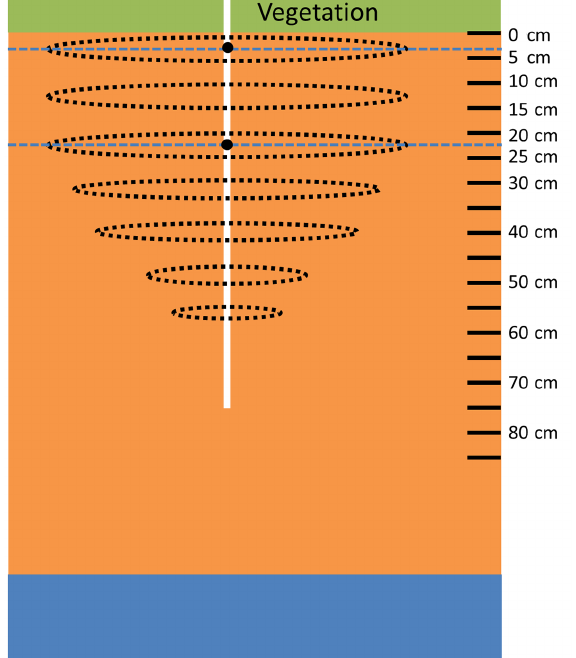
Figure 2. Sketch of the localization scheme for soil moisture at a site where soil moisture is measured at 0–5 and 20–25cm (marked by filled black circles). The depths on the right represent the nu- merical layers. The dotted-line ovals indicate the localization areas for each layer, where the cut-off values of the covariance function increase quadratically from depths 20–25cm